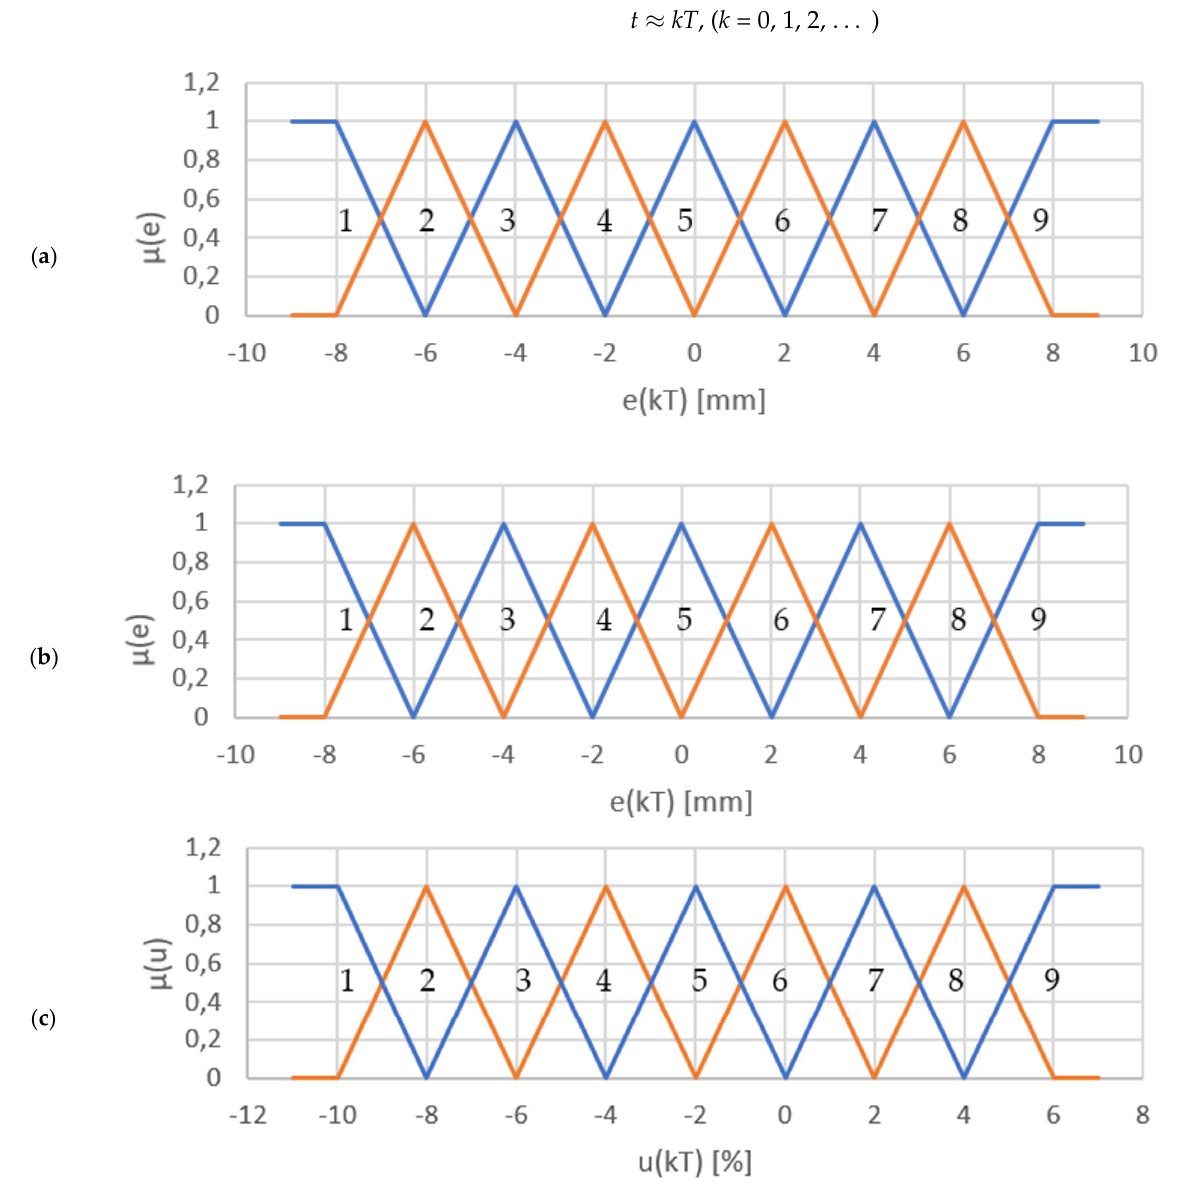
Figure 4. Membership functions for ( a ) µ(e) , ( b ) µ(e’) , ( c ) µ(u).